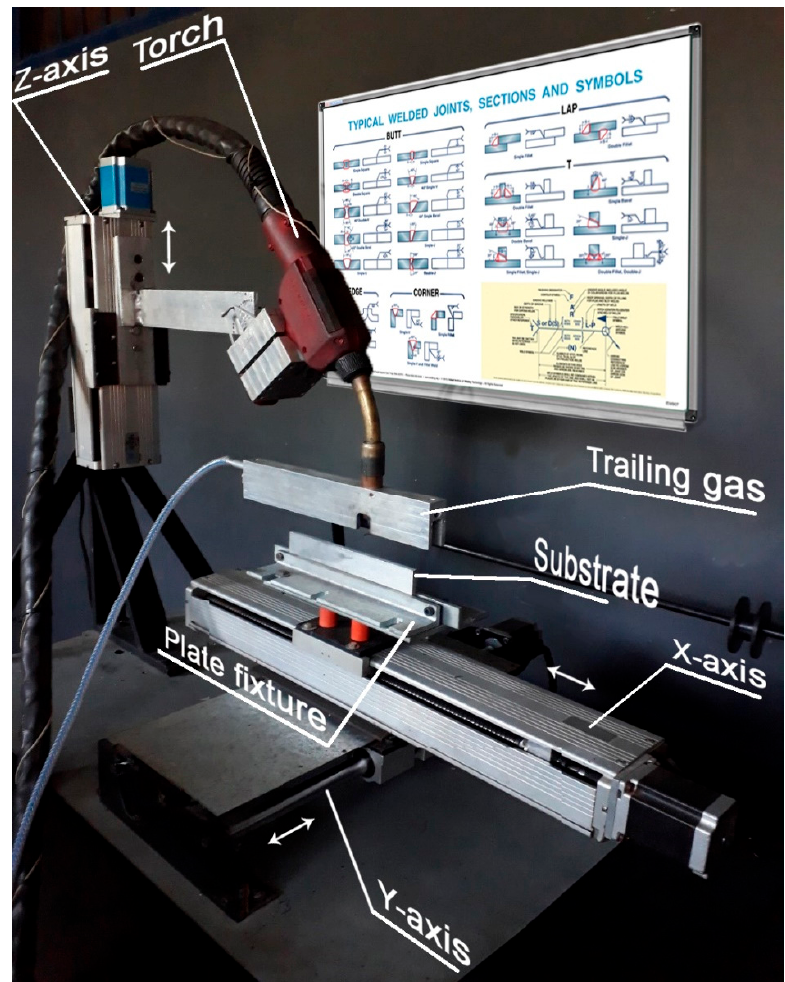
Figure 3. Experimental rig.